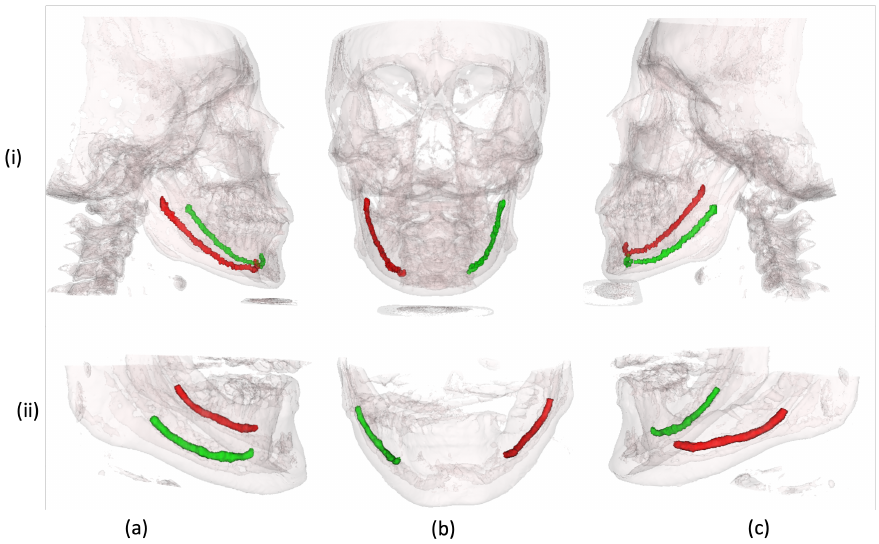
Figure 3. Three-dimensional rendered CBCT scans with left and right mandibular canal annotations. ( i ) Samples from our dataset. ( ii ) Samples from public dataset [27]. ( a – c ) the right, frontal and left side views of CBCT volumes,